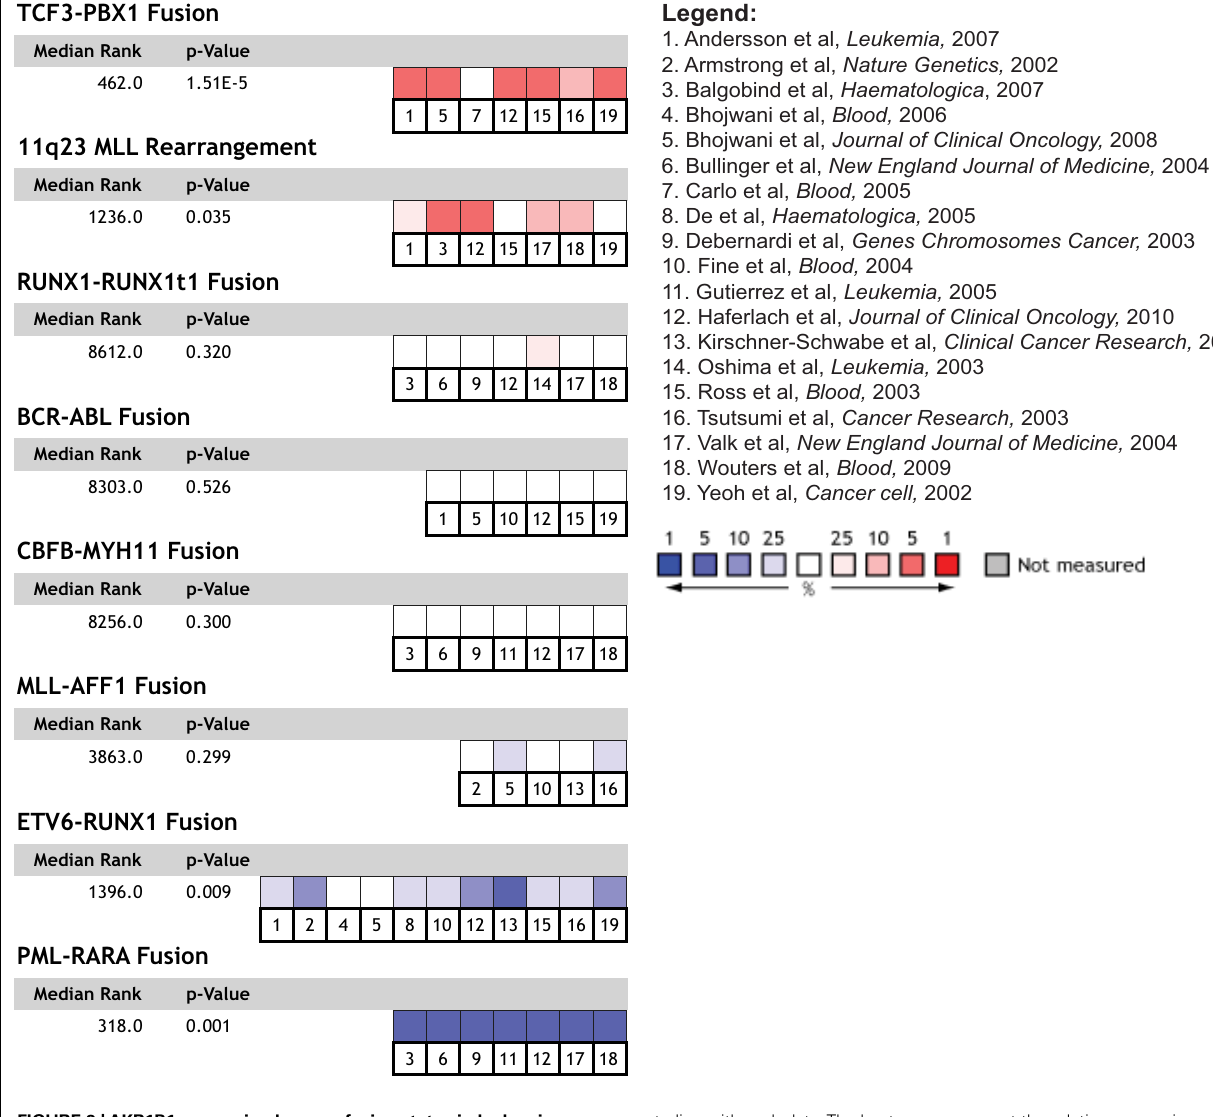
FIGURE 2 |AKR1B1 expression by gene fusion status in leukemia patients. AKR1B1 mRNA expression in leukemia patients with specific gene fusions and chromosomal rearrangements was compared to corresponding leukemia patients without the fusion across all leukemia types and for all such events where Oncomine contained multiple